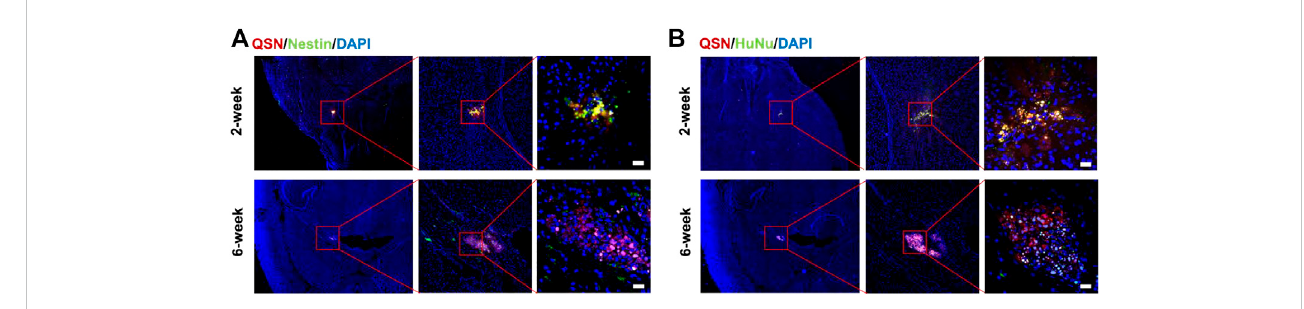
FIGURE 4 Transplantation of QSN-labeled H7NSCs in the mouse brain. QSN-labeled H7NSCs in the mouse brain at 2 and 6 weeks post transplantation were co- stained with (A) Nestin, a typical marker of human neuronal stem cells, (B) human nuclear marker, and DAPI. Scale bar: 20 μ